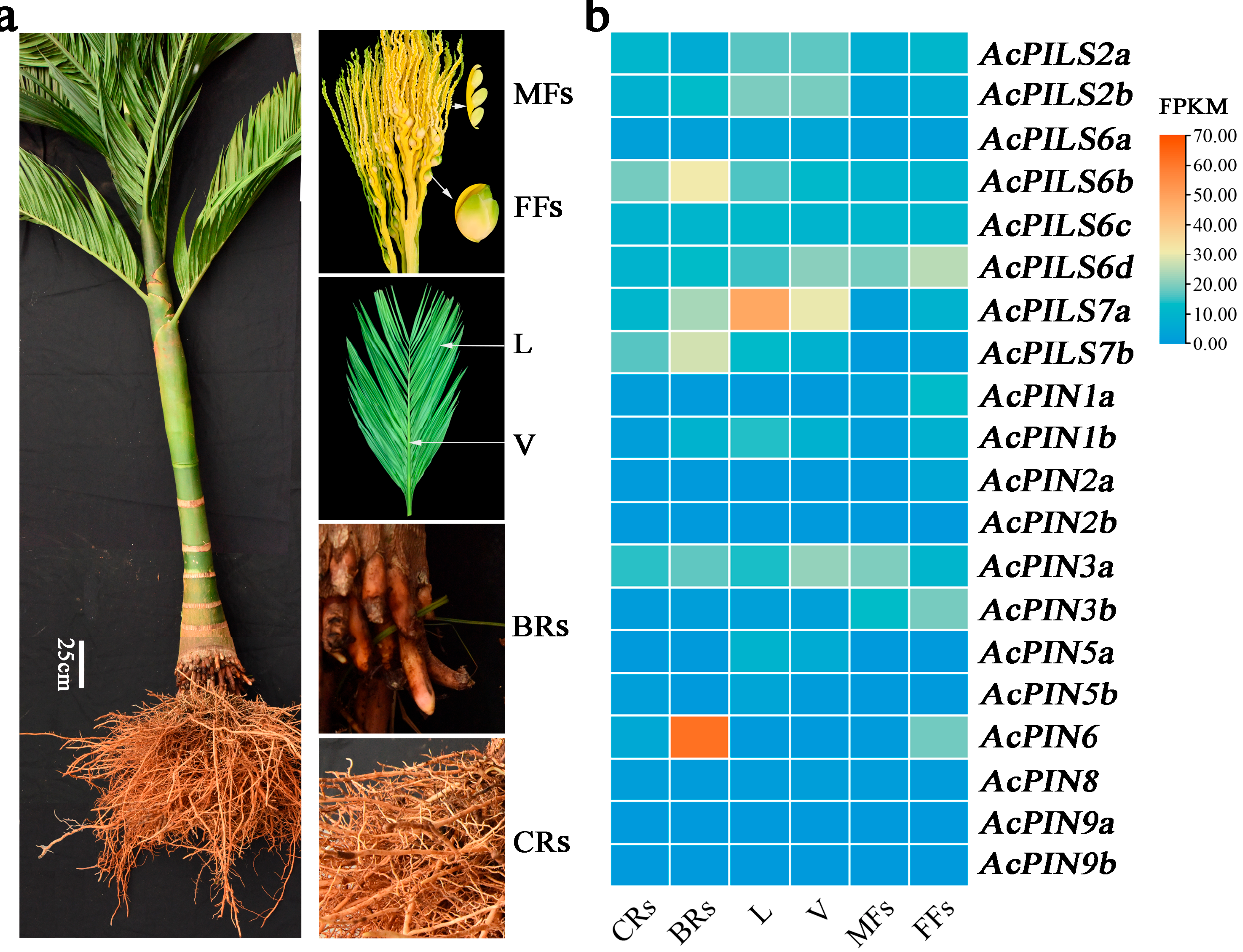
Figure 3. Morphological characteristics and AcPIN and AcPILS family gene expression profiles of Areca catechu . ( a ) Morphological characteristics A. catechu . CRs: Crown roots, BRs: Brace roots, L: Leaf, V: Vein, MFs: Male flowers, FFs: Female flowers. ( b ) Expression analysis of AcPIN and AcPILS genes of A. catechu showed that AcPIN6 had the highest expression level in brace roots. Fragments per Kilobase Million (FPKM) values are visualized as a heat map.